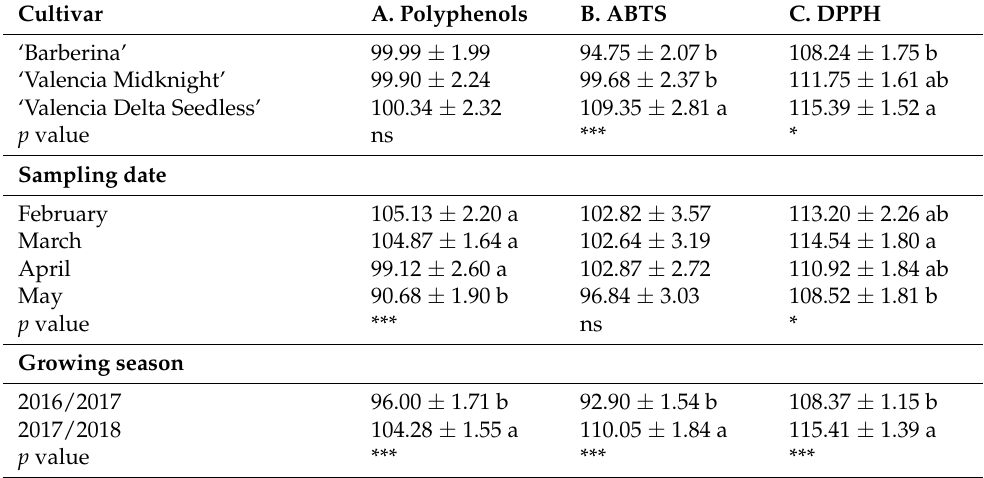
Table 4. Mean of nutritional compounds of each cultivar (‘Barberina’, ‘Valencia Midknight’ and ‘Valencia Delta Seedless’), each sampling date (February, March, April, May) and each growing season (2016/2017 and 2017/2018) tested using the same rootstock (Forner-Alcaide no. 5). (A) Mean of polyphenol content values (mg GA/100 g) ± standard error (SE). (B) Mean of antioxidant activity ABTS assay values (mg TROLOX/100 g) ± standard error (SE). (C) Mean of antioxidant